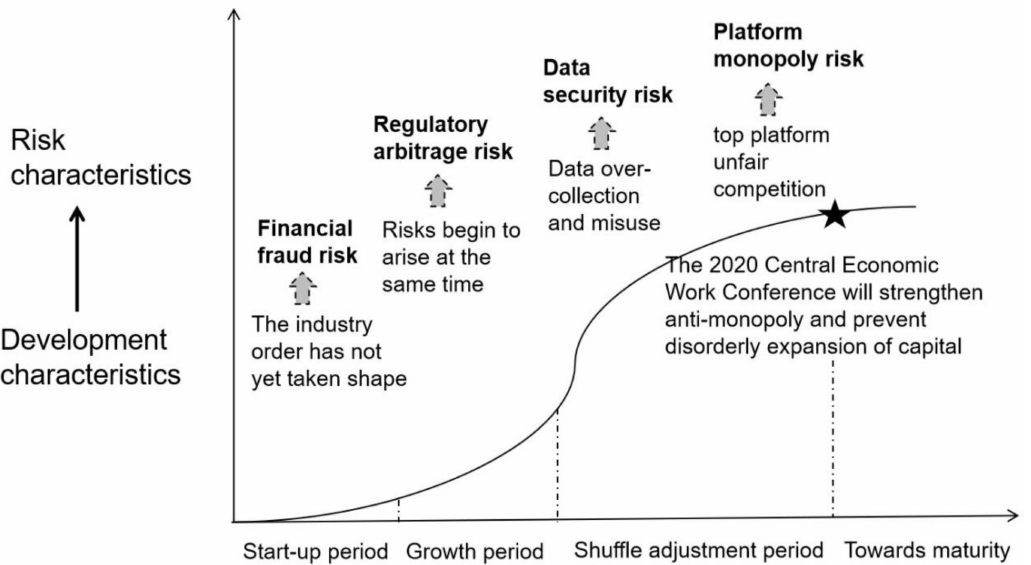
Figure 1. The main stages of China’s Fintech development and corresponding risk